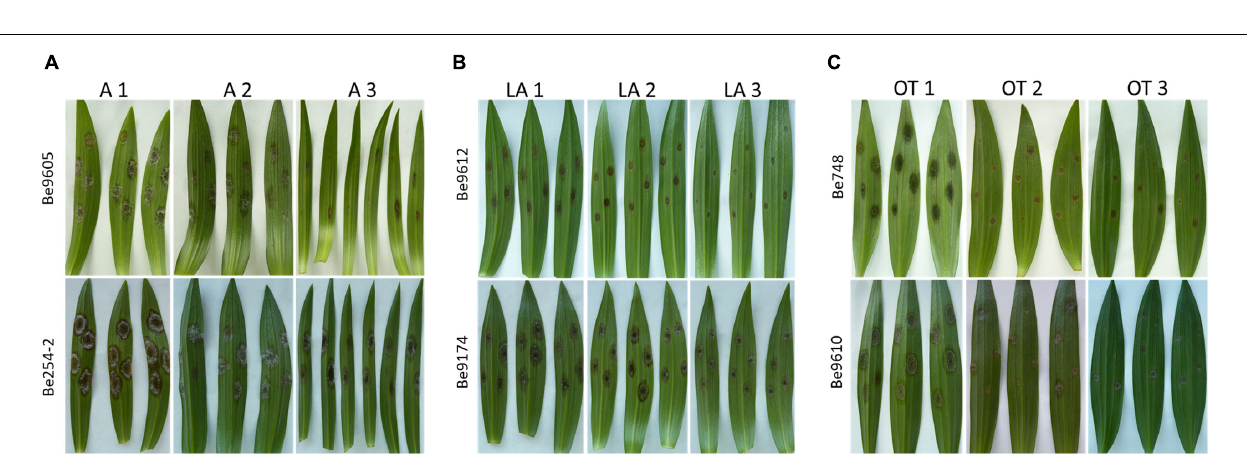
Frontiers in Plant Science |